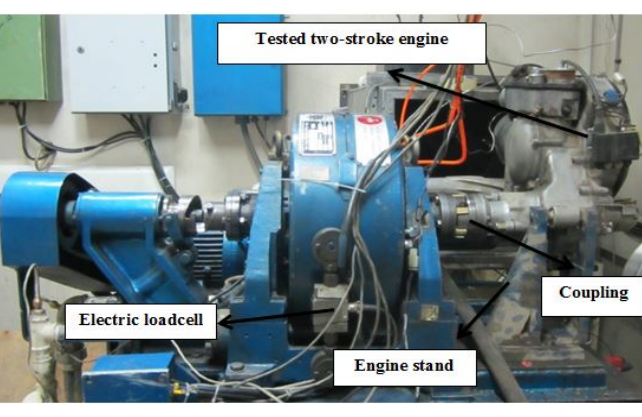
Figure 6. Engine test stand and the applied dynamometer.